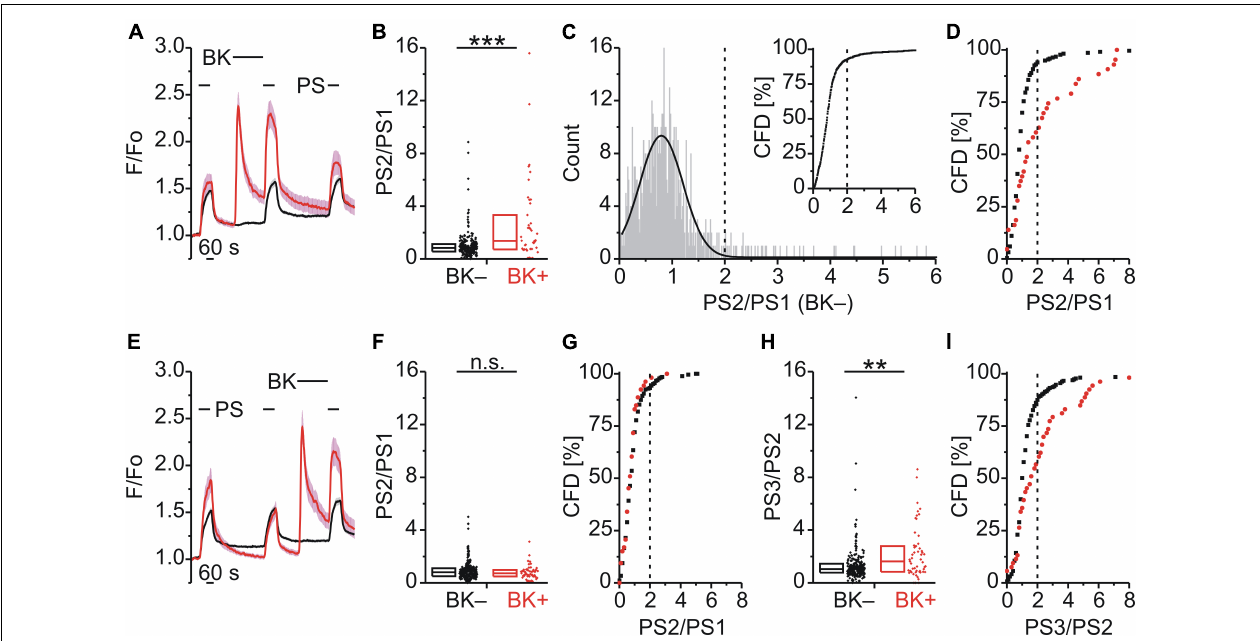
FIGURE 1 | Bradykinin sensitizes calcium responses to pregnenolone sulfate in DRG neurons. (A–D) Calcium signals over time from mouse DRG neurons (A) during three applications of pregnenolone sulfate (PS; 40 µ M) with bradykinin (BK; 0.5 µ M) applied between PS1 and PS2. Cells that showed an increase in calcium to BK are indicated in red (BK+; A,B,D , 43 neurons) and those that did not in black (BK–; A,B,D , 216 neurons). To assess the effect of BK on PS-evoked calcium response amplitude the ratio PS2–PS1 amplitude (PS2/PS1) was determined for all cells that did not respond to BK ( C , 587 neurons, from Figures 1 , 2D–F ). This distribution of PS2/PS1 ratios was fit by a Gaussian function ( C , solid black line) and the fit parameters were used to define a threshold corresponding to the mean plus three standard deviations ( C , broken vertical line at 2.0). Cells with ratio values above threshold were considered to be sensitized and plotting PS2/PS1 values cumulatively ( C , inset; CFD, cumulative frequency distribution) illustrates that in this control group 7.5% of values were above this threshold. For application of BK between PS1 and PS2, PS2/PS1 ratios are shown as a simple distribution ( B , boxes indicate quartiles and centerline median) and as CFD (D) . Each dot-like symbol in (B) , ( C , inset), and (D) represents the ratio value calculated for a single, individual cell. (E–I) Calcium signals over time (E) from mouse DRG neurons during repeat application of PS with BK applied between PS2 and PS3 (BK+, 53 neurons; BK–, 265 neurons). Control PS2/PS1 ratios are shown as a simple distribution (F) and CFD (G) . PS3/PS2 ratios are shown as a simple distribution (H) and CFD (I) . Two ratio values (“35.4” and “28.7”) of the BK– group were not shown in (H) for better visibility, but were included in the analysis. Values derive from sixteen measurements with cells from two mice. BK+ and BK– groups (B,F,H) were compared with Mann-Whitney U -tests. ** P < 0.01; *** P < 0.001; n.s., not